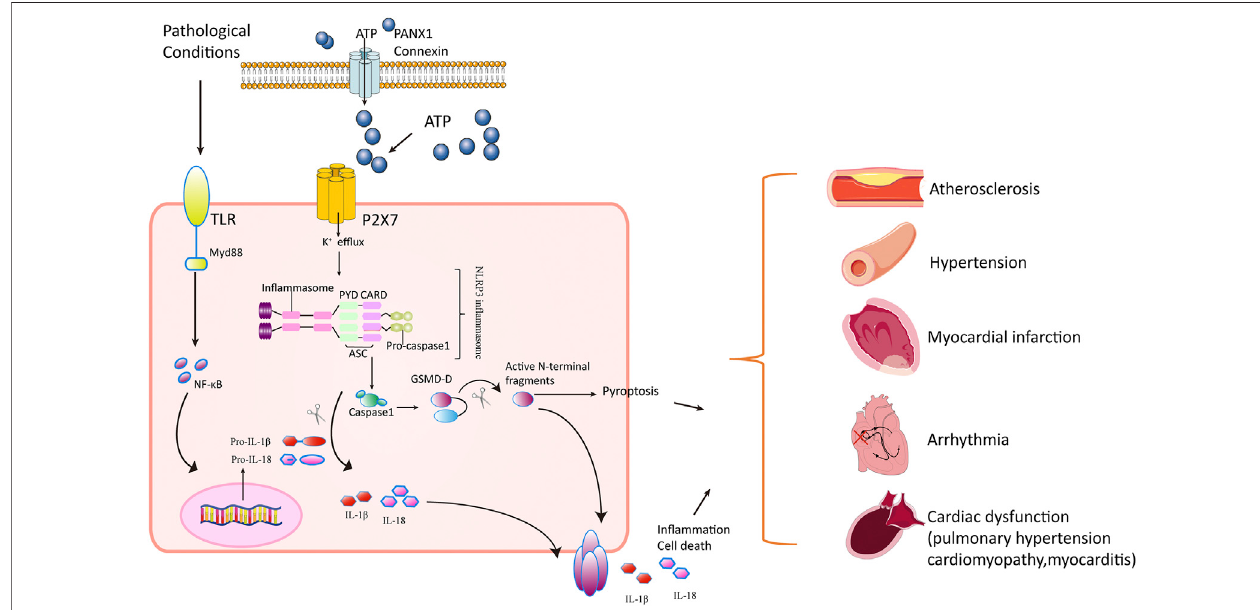
FIGURE 1 | Mechanisms of P2X ’ s action in cardiovascular disorders. In pathological stress including hypoxia/ischemia/hyperglycemia, the Toll-like 7 receptor receptors(TLRs)areactivated,producingprogenitorsofin fl ammatorycytokinessuchaspro-IL-1 β andpro-IL-18.Meanwhile,theP2X7receptorisactivatedinresponse to ATP released through PANX1 and connexins in cardiomyocytes. The openness of P2X7 receptor leads to K + ef fl ux and Ca 2+ in fl ux, triggering NLRP3 in fl ammasome assembly (a circular platform consisting of NLR, ASC, and pro – caspase-1). NLRP3 in fl ammasomes convert pro – caspase-1 into active caspase-1. Caspase-1 cleaves the inactive pro – IL-1 β and pro – IL-18 cytokines into active cytokines IL-1 β and IL-18, respectively, and cuts GSDM-D into active N-terminalfragment. The active form of GSDM-D induces cell membrane disruption through their pore-forming activity and by promoting pyroptosis and releasing IL-1 β and IL-18. The in fl ammatory response mediated by cytokines and pyroptosis contributes to pathology in atherosclerosis, hypertension, pulmonary hypertension, myocardial infarction, arrhythmia, cardiomyopathy, and autoimmune myocarditis.